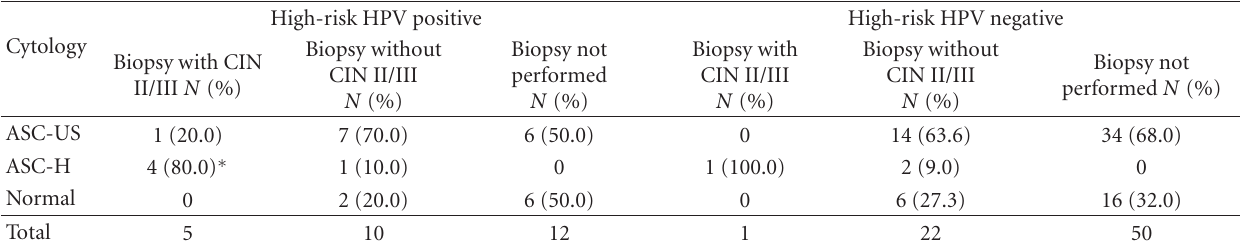
Table 5: Presence of CIN II/III in biopsies, in relation to positivity for high-risk HPV through hybrid capture, and reclassification of ASCUS cytology according to Bethesda